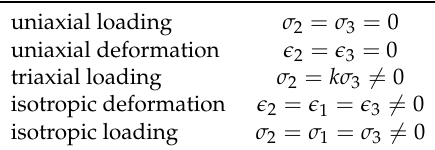
Figure 2. Illustration of the computational supercell under triaxial tensile loading. Stress tensor components are denoted using the Voigt notation. Table 1. Types of the applied